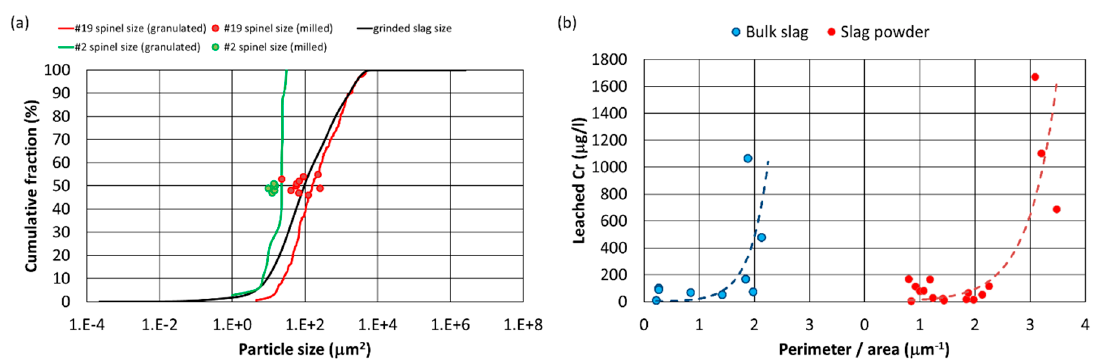
Figure 8. Combined effect of Cr 2 O 3 concentration and slag basicity on Cr-bearing phases dimension (p/A). Appl. Sci. 2018 , 8 , x FOR PEER REVIEW